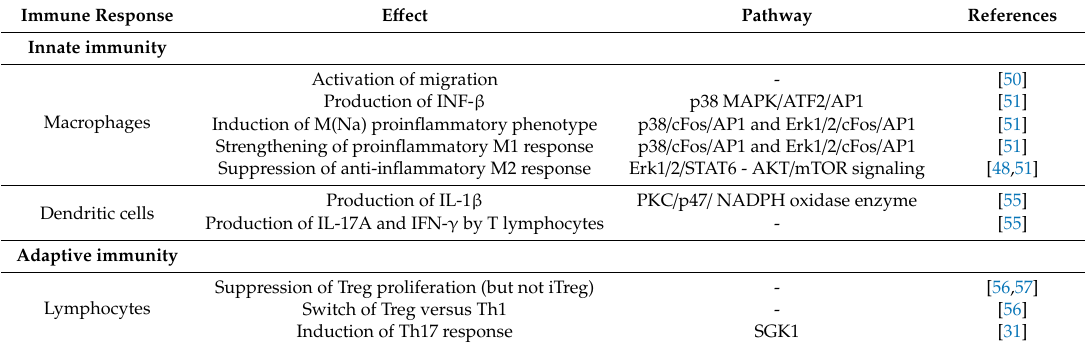
Table 1. E ff ect of sodium on immune response in vitro and in vivo.